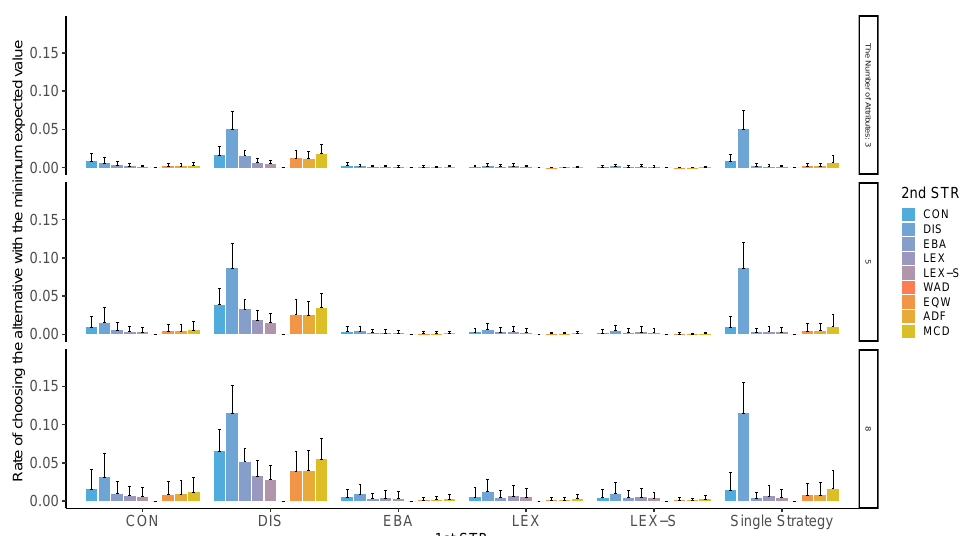
Figure A11. Worst-choice rate in two-stage decision-making when only two alternatives are left in the second stage for the different numbers of attributes. Note: ADF: additive difference; CON: conjunctive; DIS: disjunctive; EBA: elimination by aspects; EQW: equal-weighted strategy; LEX: lexicographic; LEX-S: lexicographic semi-order; MCD: majority of confirming dimensions; STR: strategy; WAD: weighted additive.